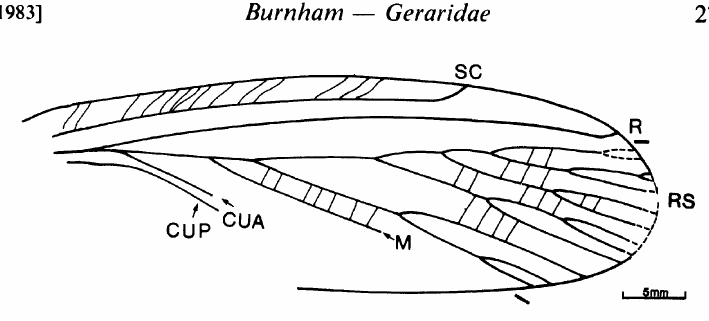
Fig. 12. Gerarus collaris, drawing of hind wing, based on holotype YPM 34.